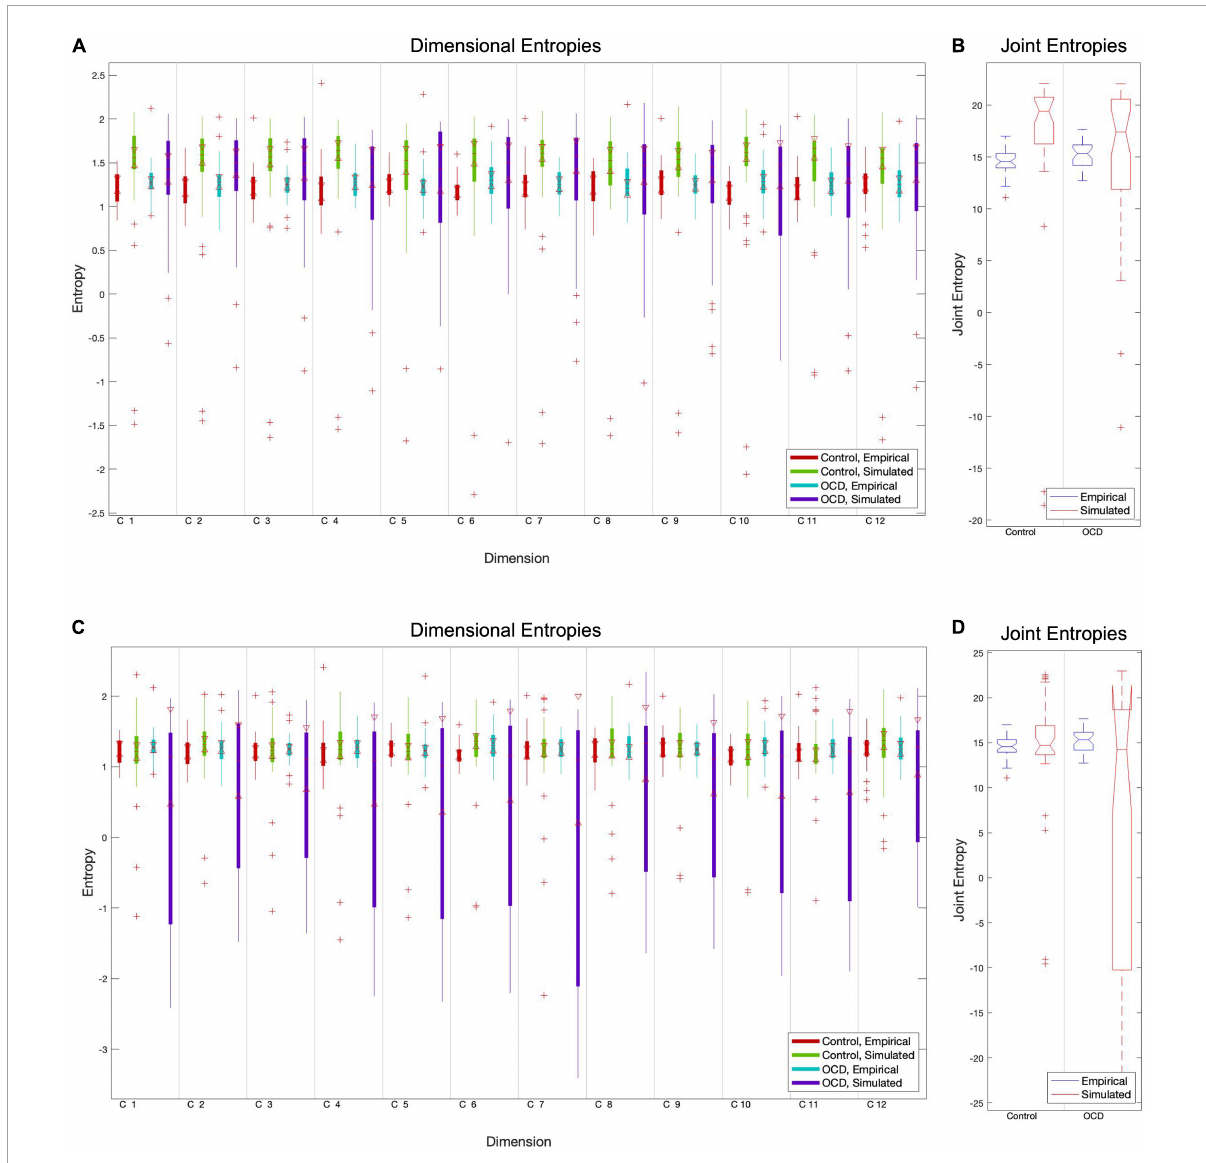
FIGURE2 The particle swarm fitting algorithm, like most optimization algorithms, minimizes a cost function to determine how well the model predicts real data. We chose the Euclidean distance between empirical and simulated entropy vectors as a cost function due to its conceptual simplicity and confirmed its superiority versus absolute maximum distance. Comparisons of component-level entropy distributions pre-fit (A) and post-fit (C) demonstrate that this method does improve the model for controls. Comparisons of pre-fit (B) and post-fit (D) joint entropy confirm this. While optimization brings the mean entropies of patient models closer to those of empirical subjects, its performance is quite inconsistent in this group. This is reflected in the extremely high variance in post-optimization dimensional and joint entropies (C,D)